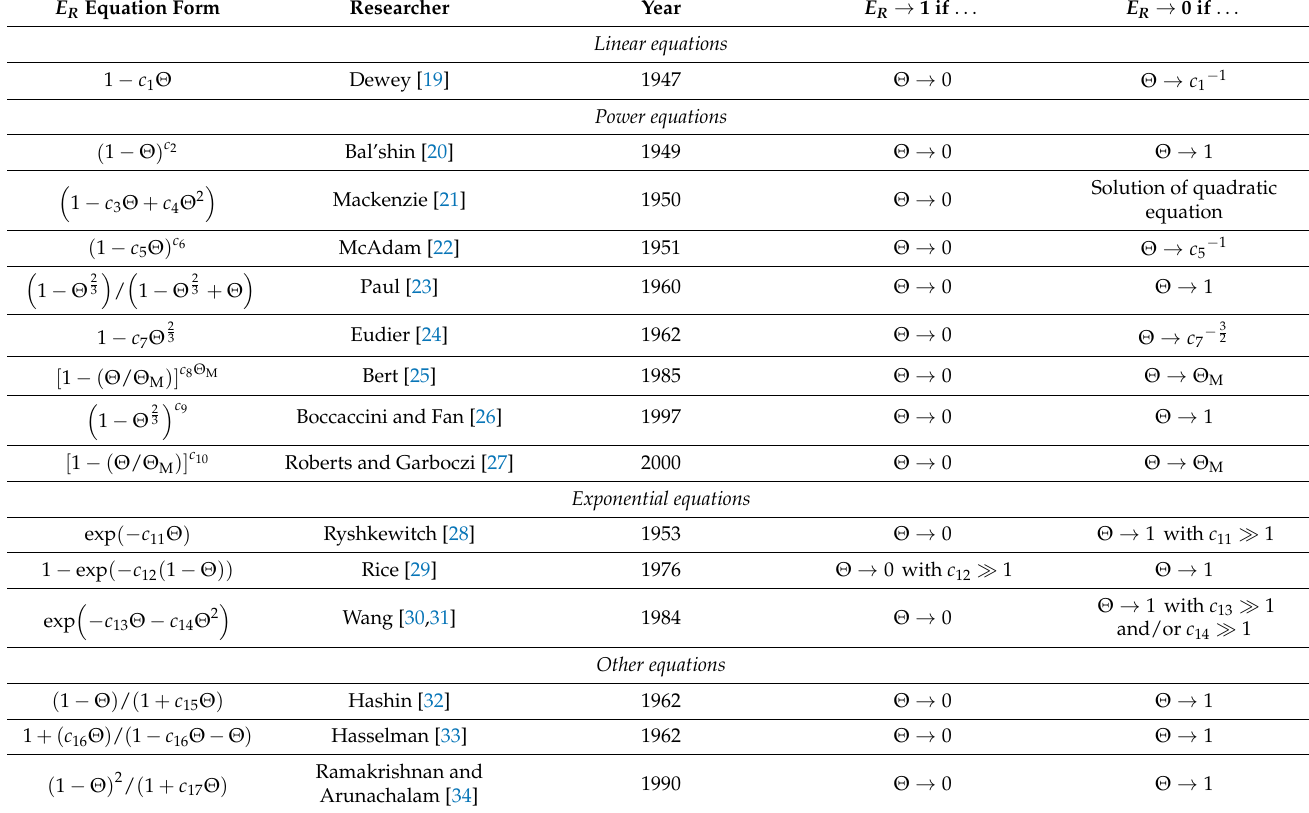
Table 1. Summary of equations for the relative Young’s modulus of porous materials ( E R = E / E 0 ). Θ M is the maximum porosity of the powder mass. Parameters c 1 to c 17 are fitting